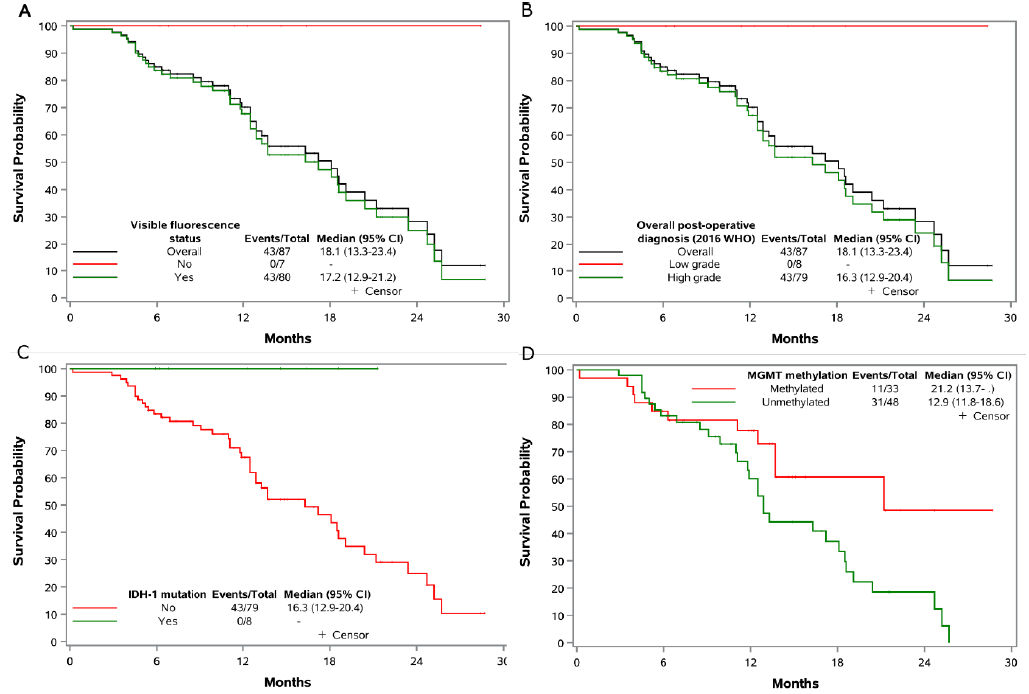
Figure 4. Overall survival in the eligible patients. Shown are Kaplan–Meier curves for overall survival. Tick marks indicate censored data. The survival time calculate from date of registration to date of death, censored if alive or lost to follow-up. ( A ) Overall survival of overall population and stratified by visible fluorescence; ( B ) Overall survival of overall population and stratified by post-operative diagnosis (2016 WHO); ( C ) Overall survival stratified by IDH-1 mutation status; ( D ) Overall survival stratified by MGMT methylation status. Two patients optout from study, the MGMT methylation status was not available for 6 patients.